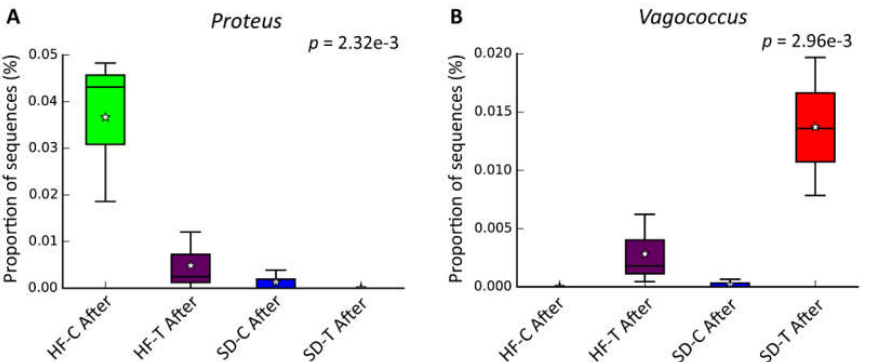
Figure 7. Effect of exercise training on bacterial genera profile. ( A ) Proteus ; ( B ) Vagococcus . White star represents the average of each group, and the median value is shown as a line within the box. ( p < 0.01 was considered as statistical significance, ANOVA with Tukey–Kramer post-hoc test.)